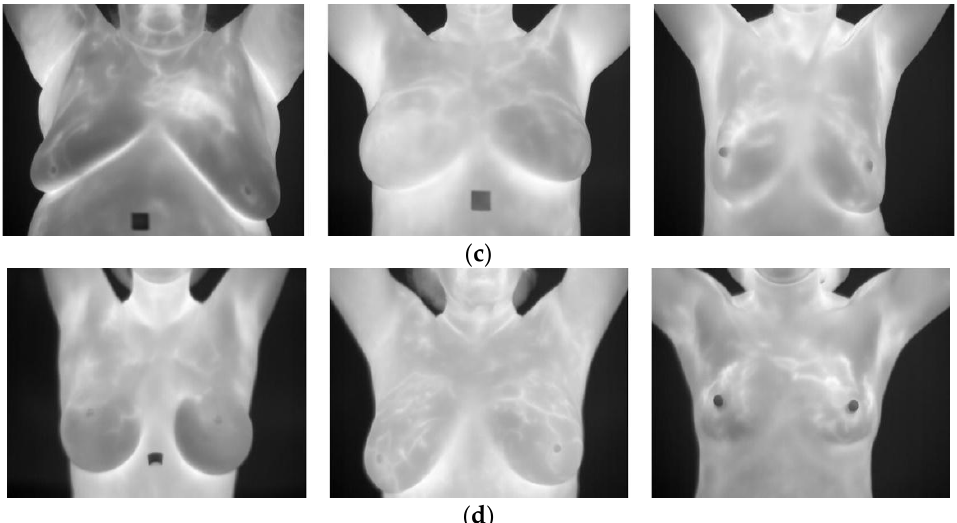
Figure 4. Sample thermal images of breasts from the dataset: ( a ) sick (Hospital of Nur-Sultan), ( b ) healthy (Hospital of Nur-Sultan), ( c ) sick (DMR), and ( d ) healthy (DMR). Table 2. Details of training, cross-validation, and testing dataset for the classification model.